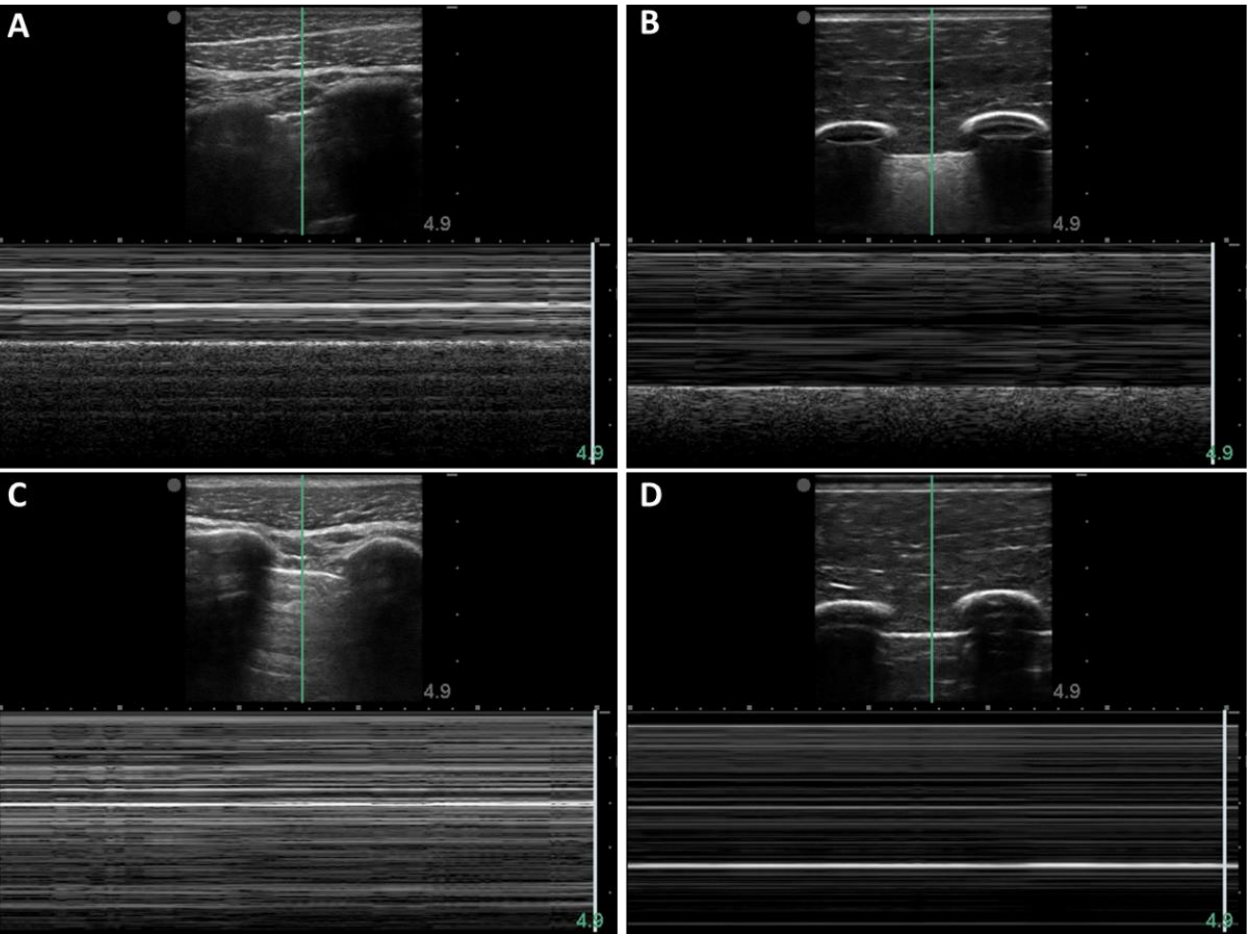
Figure 4. M-mode image comparison with porcine subjects and synthetic phantoms: ( A ) Baseline thoracic image acquired from porcine subject; ( B ) Baseline image acquired from synthetic phantom apparatus; ( C ) Post-injury image acquired from same porcine subject; ( D ) Pneumothorax positive image acquired from synthetic phantom apparatus.